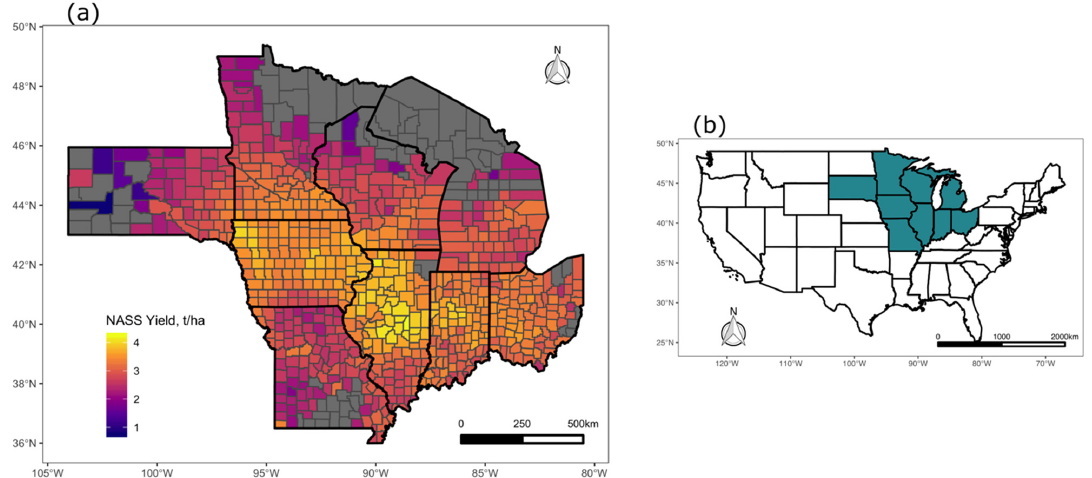
Figure 1. Study Area. ( a ) Average county yields across the period 2008–2018 from the National Agricultural Statistics Service (NASS) [41]. ( b ) Study area states (blue) in context of the continental United States.